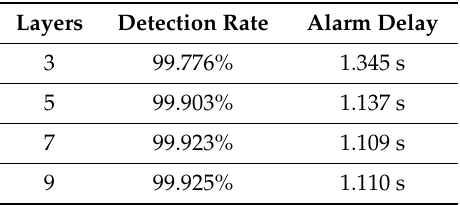
Table 1. Performance with different model layers.